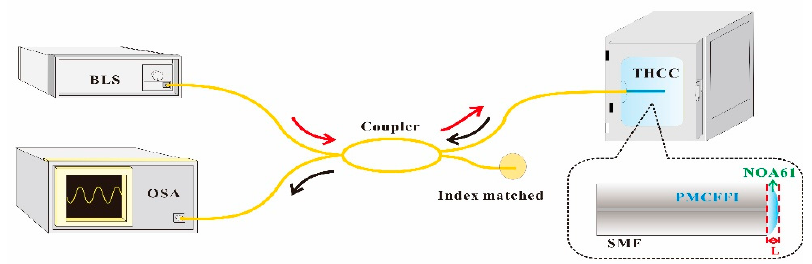
Figure 3. Schematic diagram of the PMCFFI experimental measurement